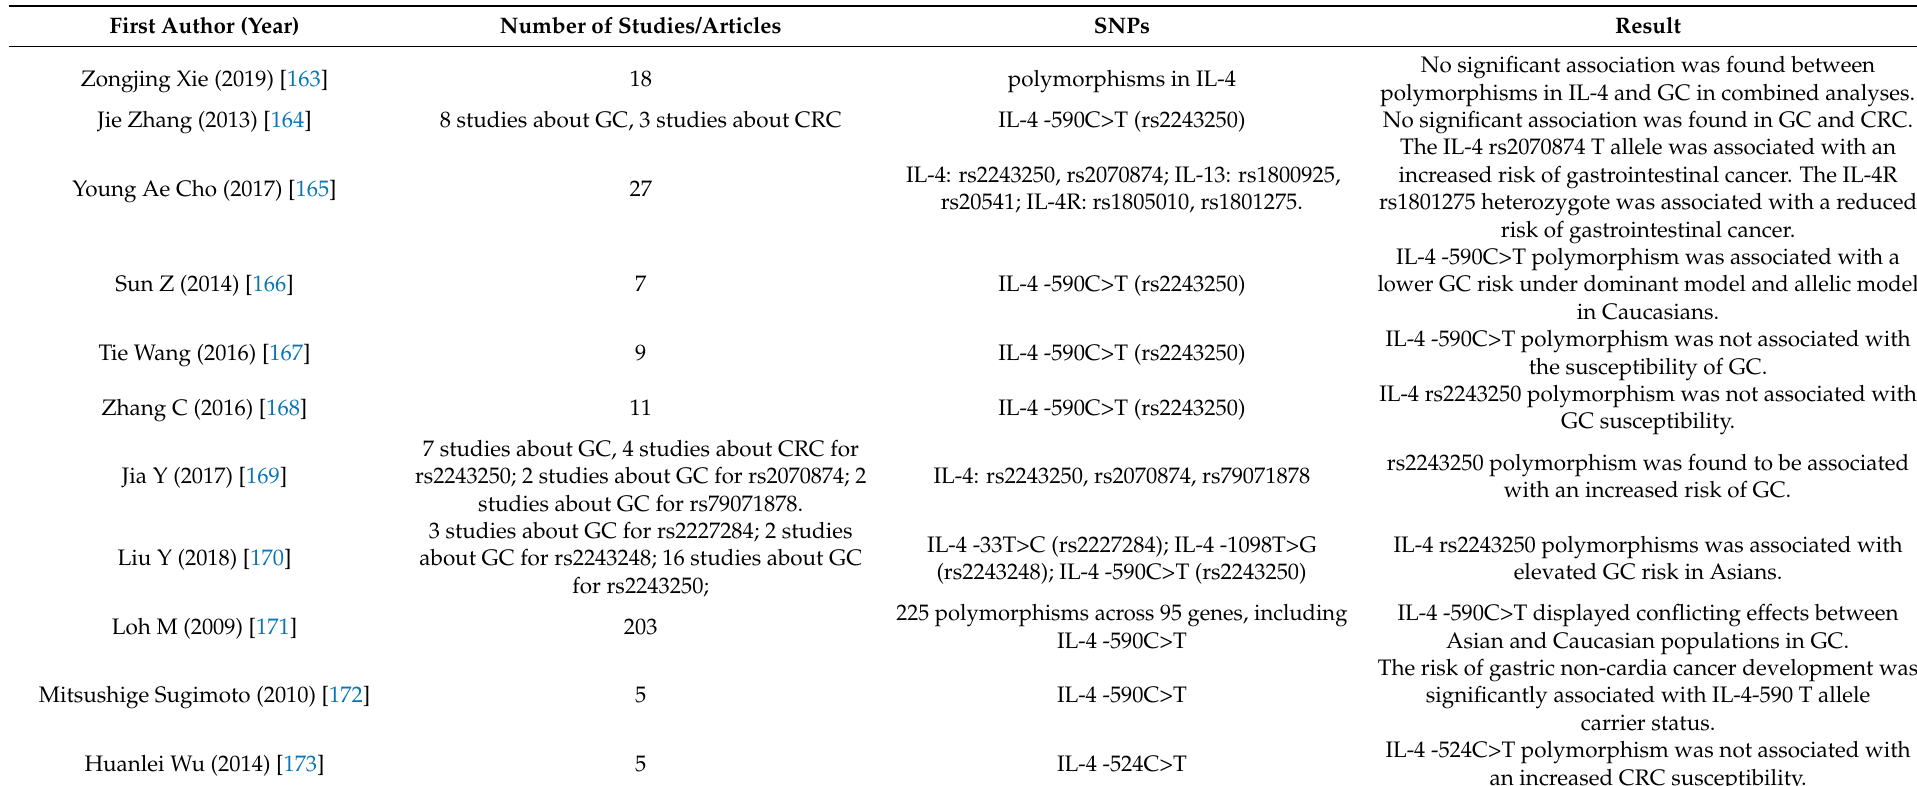
Table 2. Meta-analysis or combined studies about polymorphisms of IL-4/IL-13 and their receptors in gastric cancer (GC) and colon and rectal cancer